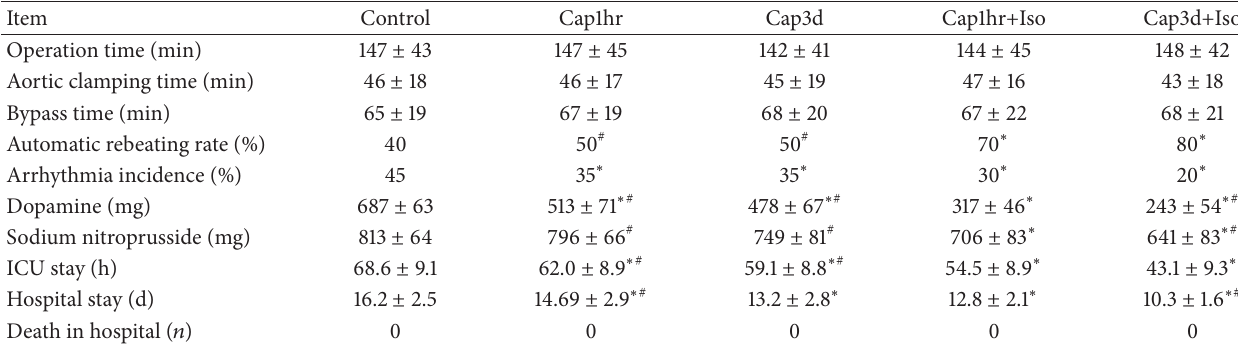
Table 2: Intraoperative and postoperative procedure characteristics of the